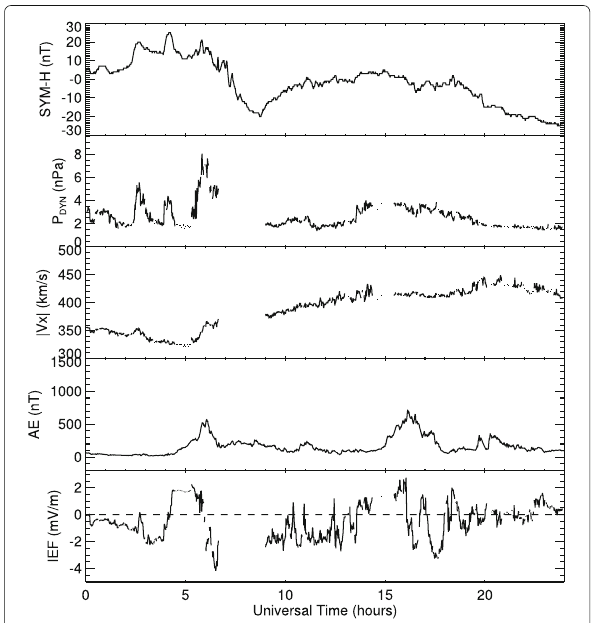
Fig. 8 The same as Fig. 7, but zoomed in on July 28 2014